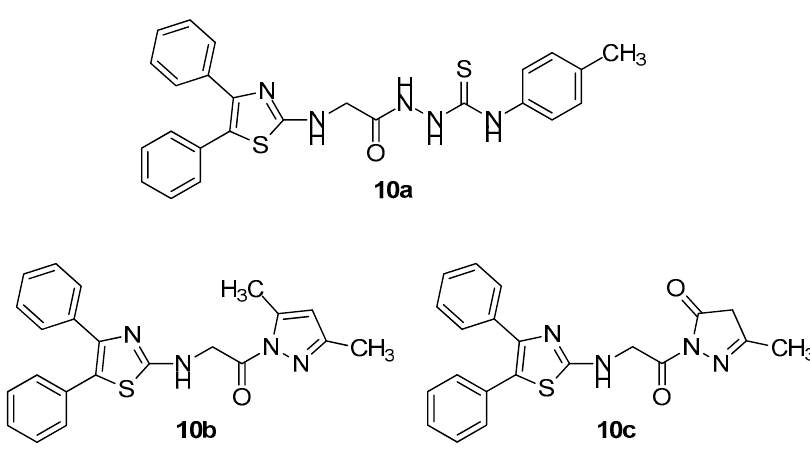
Figure 12. Chemical structures of diphenyl thiazole derivatives 10a – 10c .